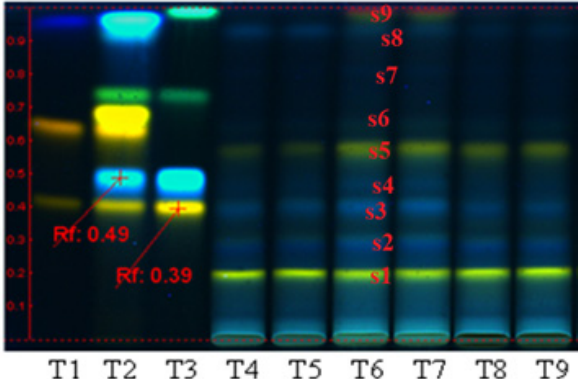
Figure 1. Qualitative assessment of polyphenolic compounds distribution in the three extracts obtained from Plantago lanceolata , by HPTLC analysis. T1: quercetin-3-O-rutinoside/rutin, quercetin-3-O-galactoside/hyperoside and gallic acid; T2: quercetin-3-O-rutinoside/rutin, chloro- genic acid, quercetin-3-O-galactoside/hyperoside, luteolin-7-O-glucoside/cynaroside, apigenin-8-C- glucoside/vitexin, caffeic acid; T3: rutin, chlorogenic acid, apigenin-7-O-glucoside/cosmosiin and kaempferol; T4–T5: polysaccharides fraction PP; T6–T7: polyphenols fraction PF; T8–T9: iridoids fraction